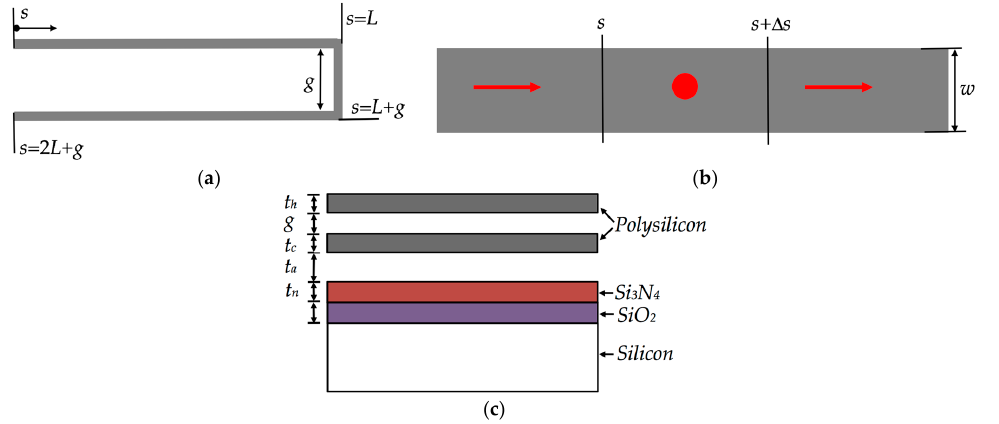
Figure 5. ( a ) Schematic of the one-dimensional model for an electrothermal actuator; ( b ) its differential element; and ( c ) cross-section of the different layers for the thermal analysis.